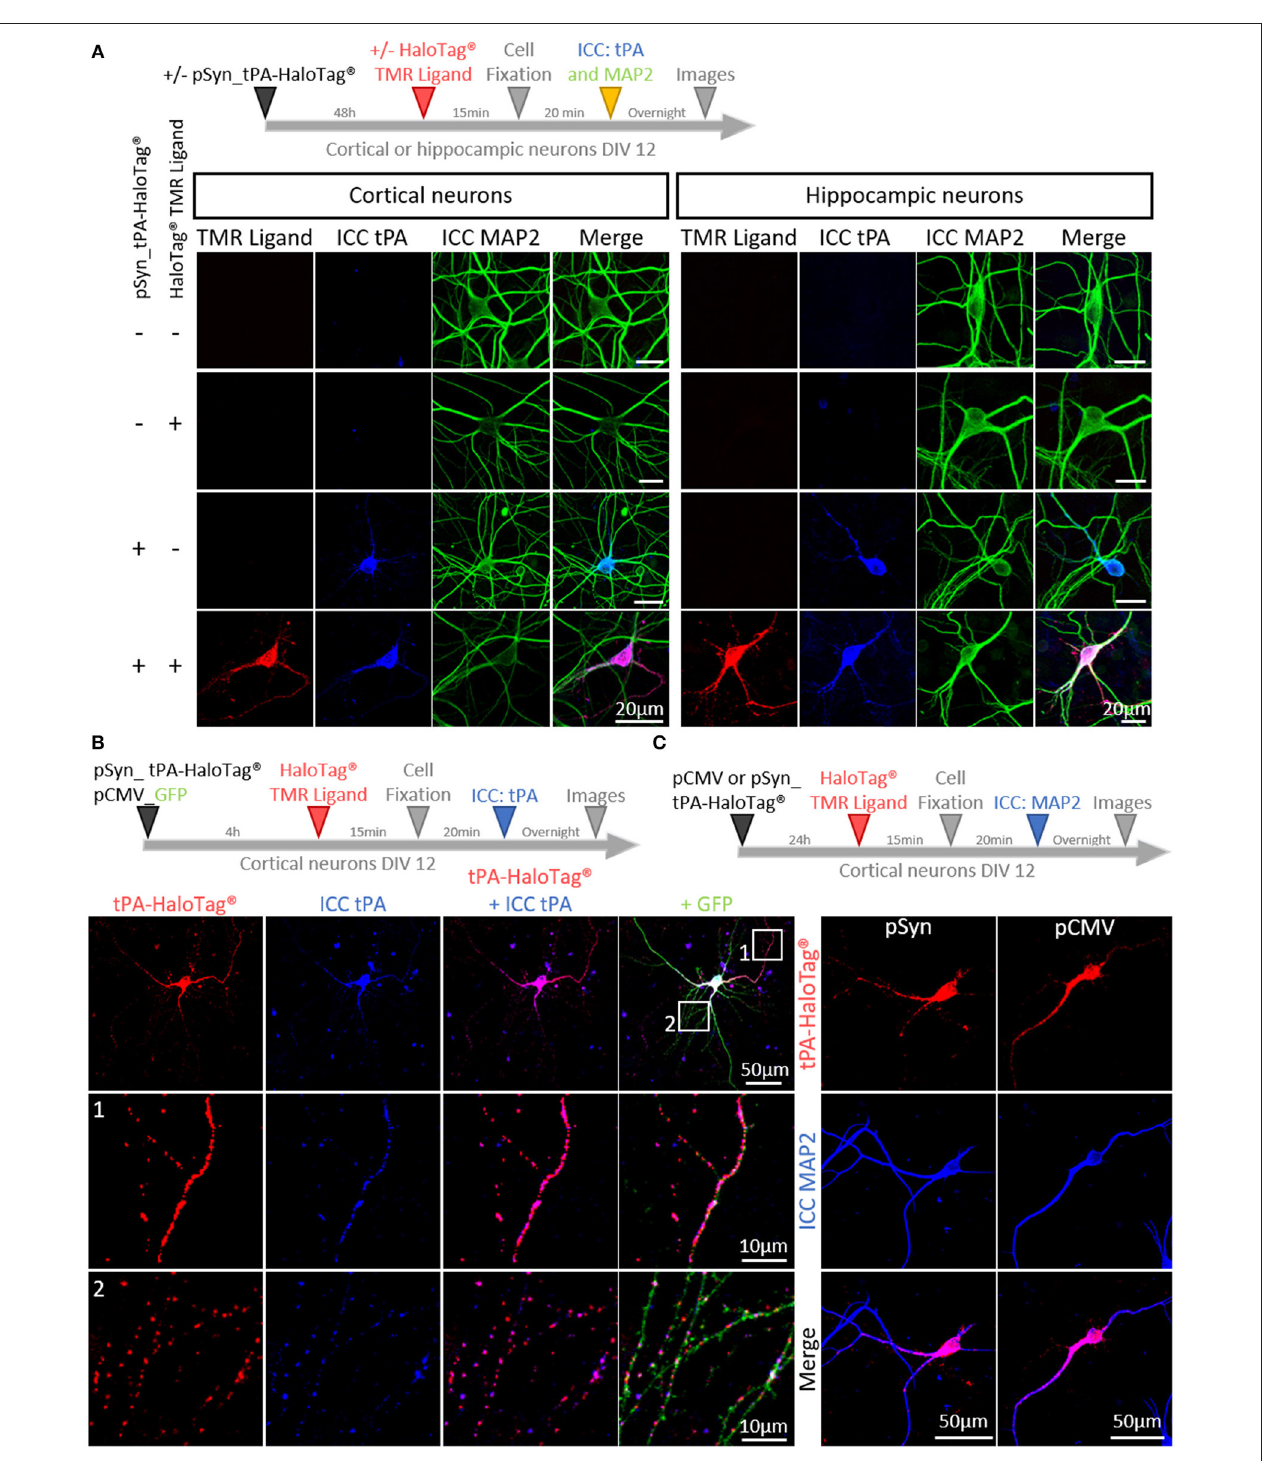
FIGURE 2 | Characterization of tPA-HaloTag ® plasmids. (A) Timeline of the experiments. Representative confocal images of cortical and hippocampal neurons transfected ( + ) or not (–) at DIV12 (Day In Vitro ) with pSyn_tPA-HaloTag ® and exposed 48h later ( + ) or not (–) to the HaloTag ® TMR ligand, together with an immunocytochemistries (ICC) against tPA (blue) and MAP2 (green). Scale Bar: 20 µ m. (B) Transfection of cortical neurons at DIV 12 with pSyn_tPA-HaloTag ® (red) and pCMV_GFP (green) plasmids, exposed 4h later to the HaloTag ® TMR ligand and ICC performed to reveal tPA (in blue). Z-stack and scale Bar: 50 µ m (whole neuron) and 10 µ m (1 and 2: whole neuron zoom). (C) Timeline of the experiments. Transfections of pCMV_tPA-HaloTag ® or pSyn_tPA-HaloTag ® (both revealed in red) and immunochemistry raised against MAP2 (in blue) show similar neuronal expressions of tPA-HaloTag ® with the two constructs. Scale of tPA-HaloTag ® with the two constructs. Scale Bar: 50 µ m (whole